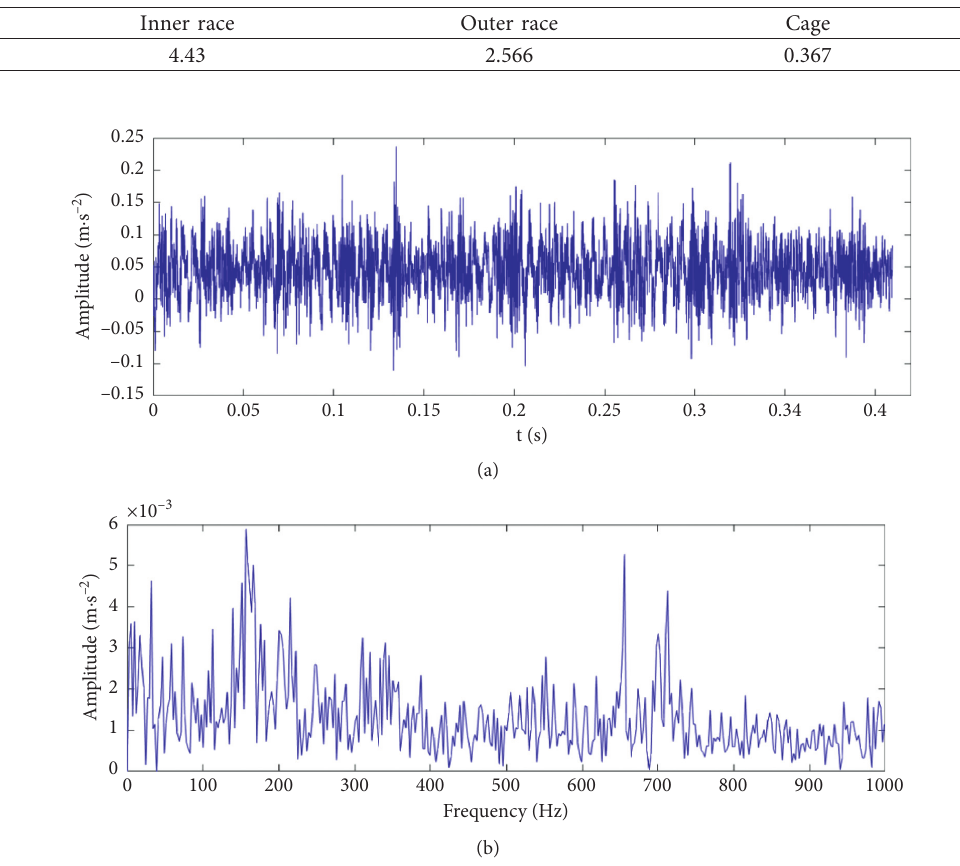
Figure 11: The tested bearing with fault. (a) The tested bearing with inner race fault. (b) The tested bearing with compound fault. Table 1: Multiple of fault frequency of each bearing component.